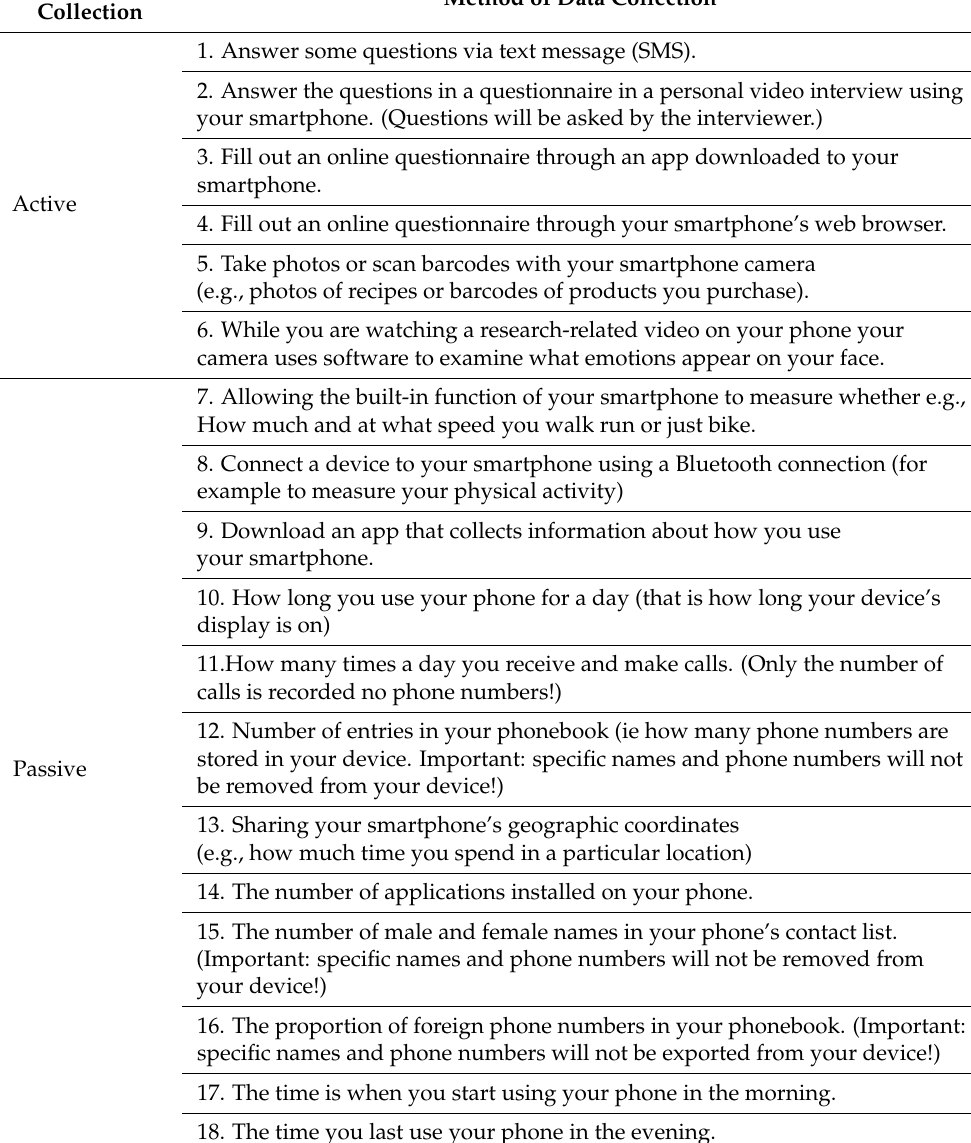
Table A5. Types of active and passive data collection